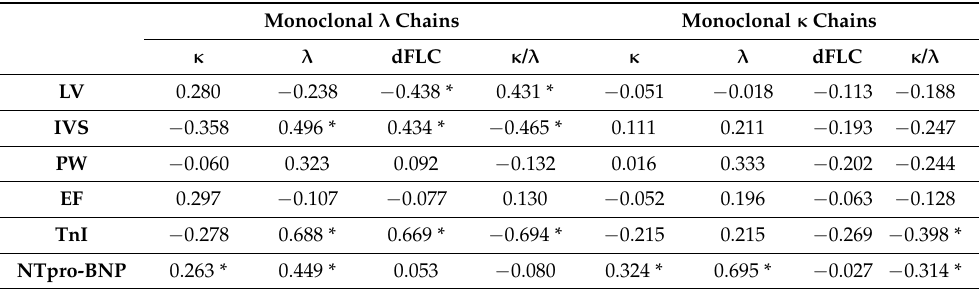
Table 10. Correlation coefficients (Rs) for κ and λ light chains, dFLC values, and κ / λ ratio with myocardium involvement parameters and echo test in the group with involvement of the myocardium by amyloids formed from monoclonal λ and κ